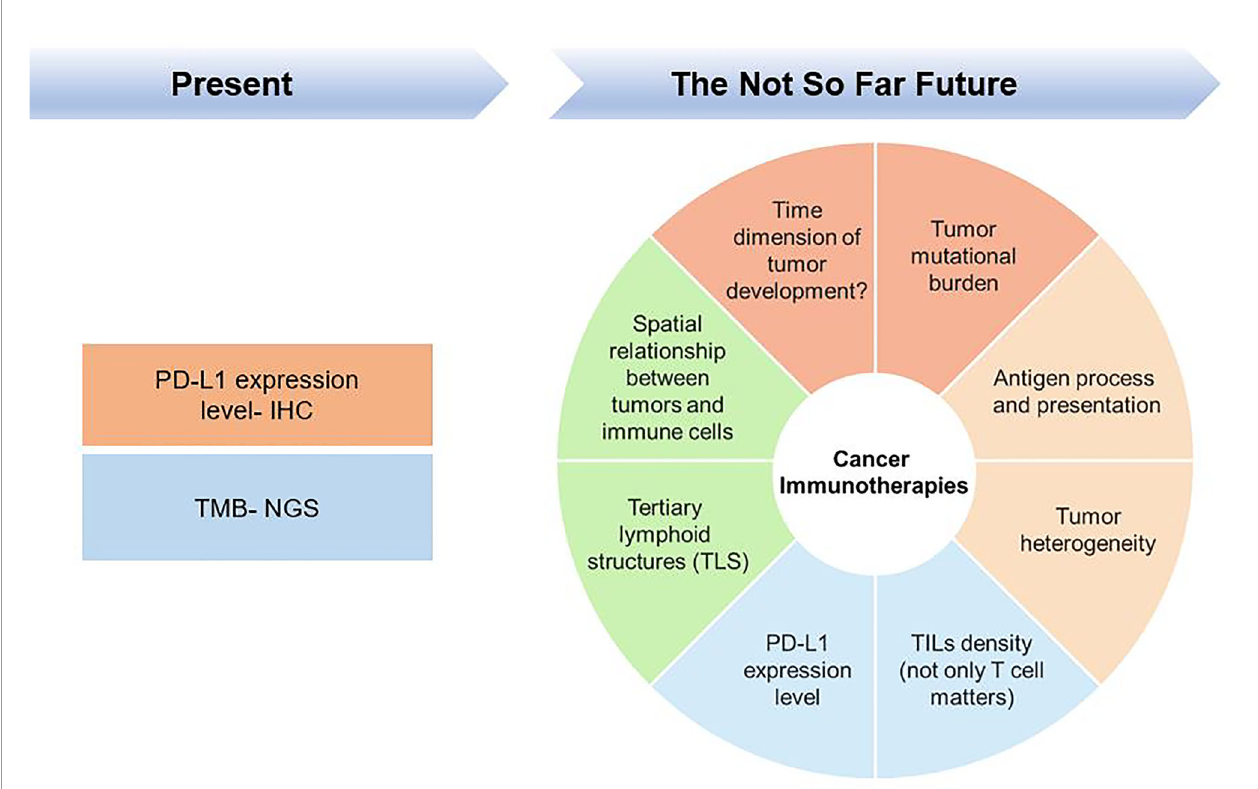
FIGURE 1 | High-dimensional biomarkers are necessary for cancer